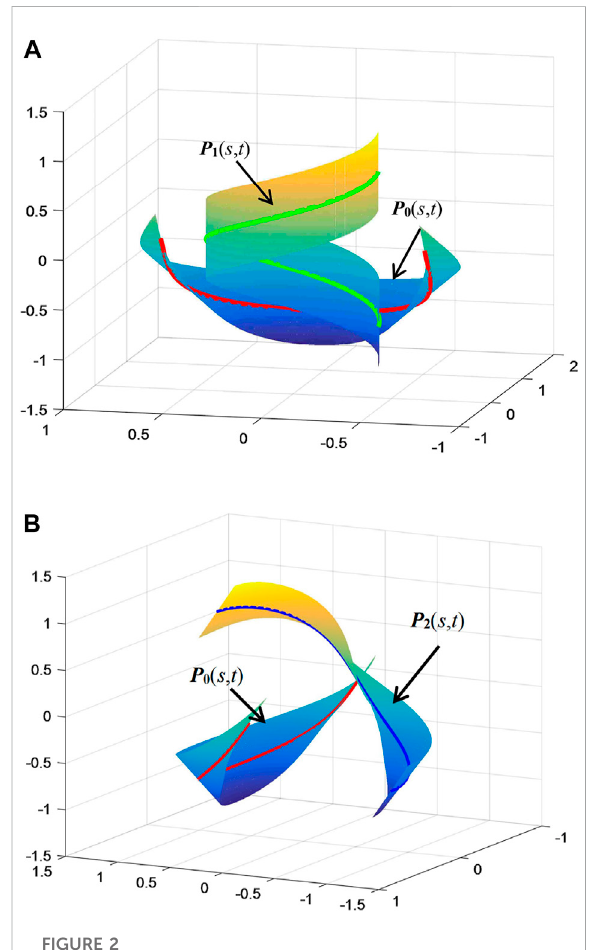
FIGURE 3 { P 0 ( s, t ) , P i ( s, t ) } interpolating { R 0 (s), R i (s)}, ( i = 1, 2 ) as common lines of